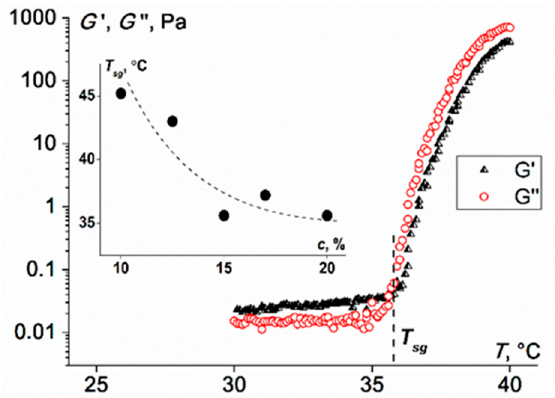
Figure 8. The dependence of storage G ′ and loss G ″ moduli on the temperature at the concentration 15 wt.%. Inset : the dependence of the sol-gel temperature on the solution concentration.